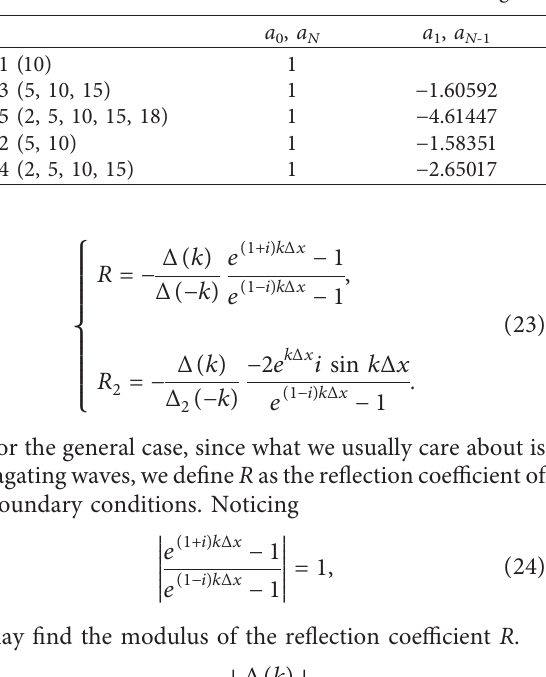
Table 1: Coefficients in matching boundary conditions MBC N (with Δ x �